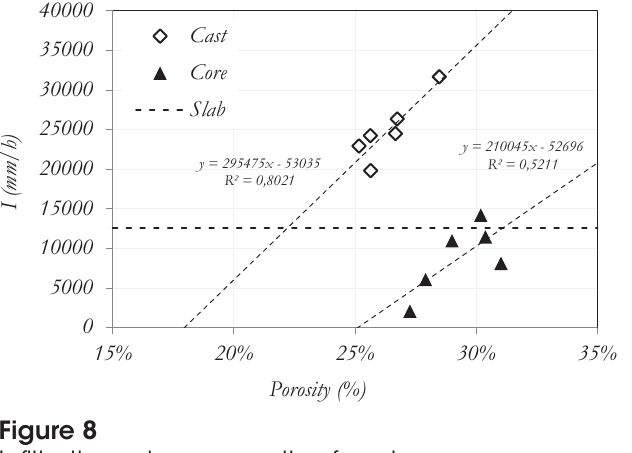
Infiltration rate vs. porosity of cast and cored